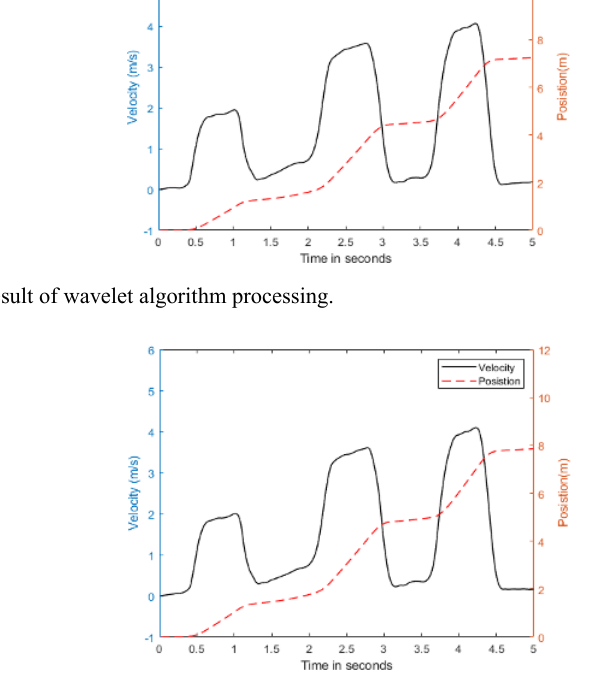
Fig. 8. The result of wavelet algorithm combined with adaptive compensation algorithm.